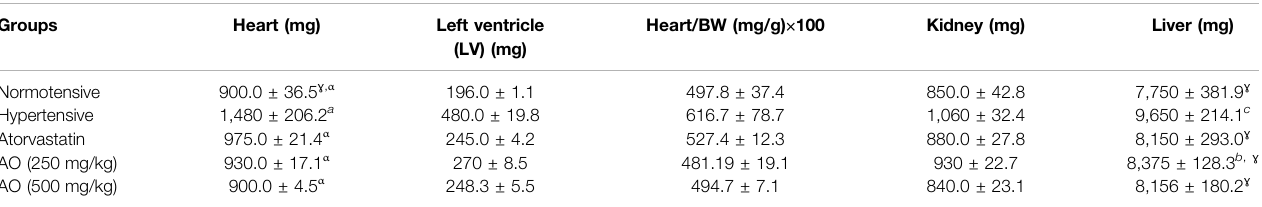
TABLE 3 | Effect of administration of Alpinia of fi cinarum on weight of various organs in chronic obesogenic diet-fed hypertensive rats.